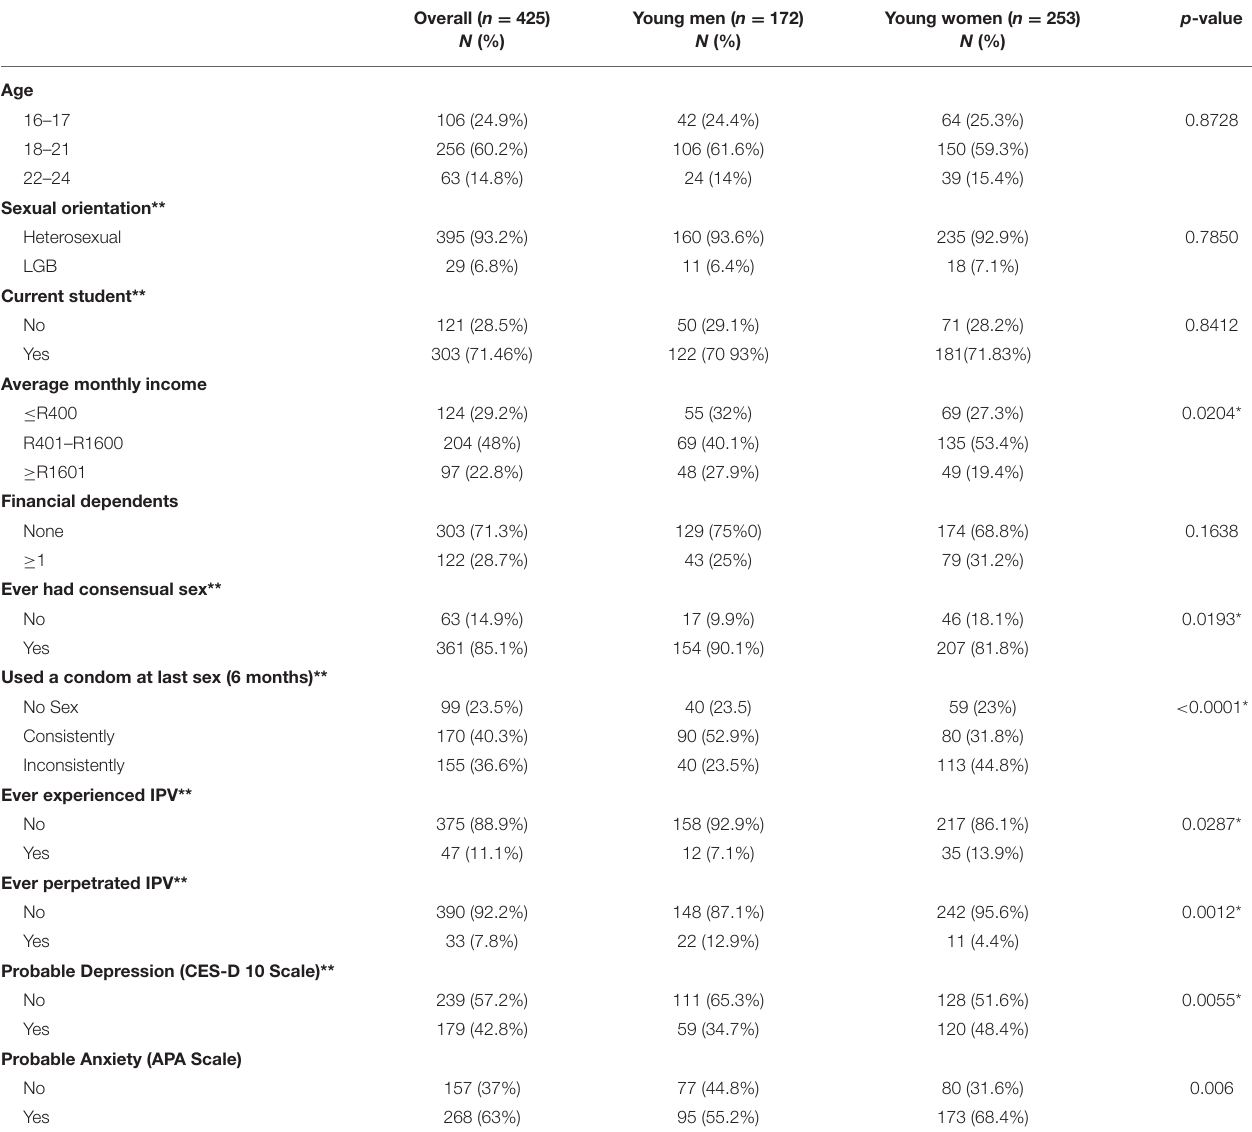
TABLE 1 | Socio-demographic, sexual behavior, violence, and mental health factors of AYAZAZI participants overall and by gender ( n = 425).